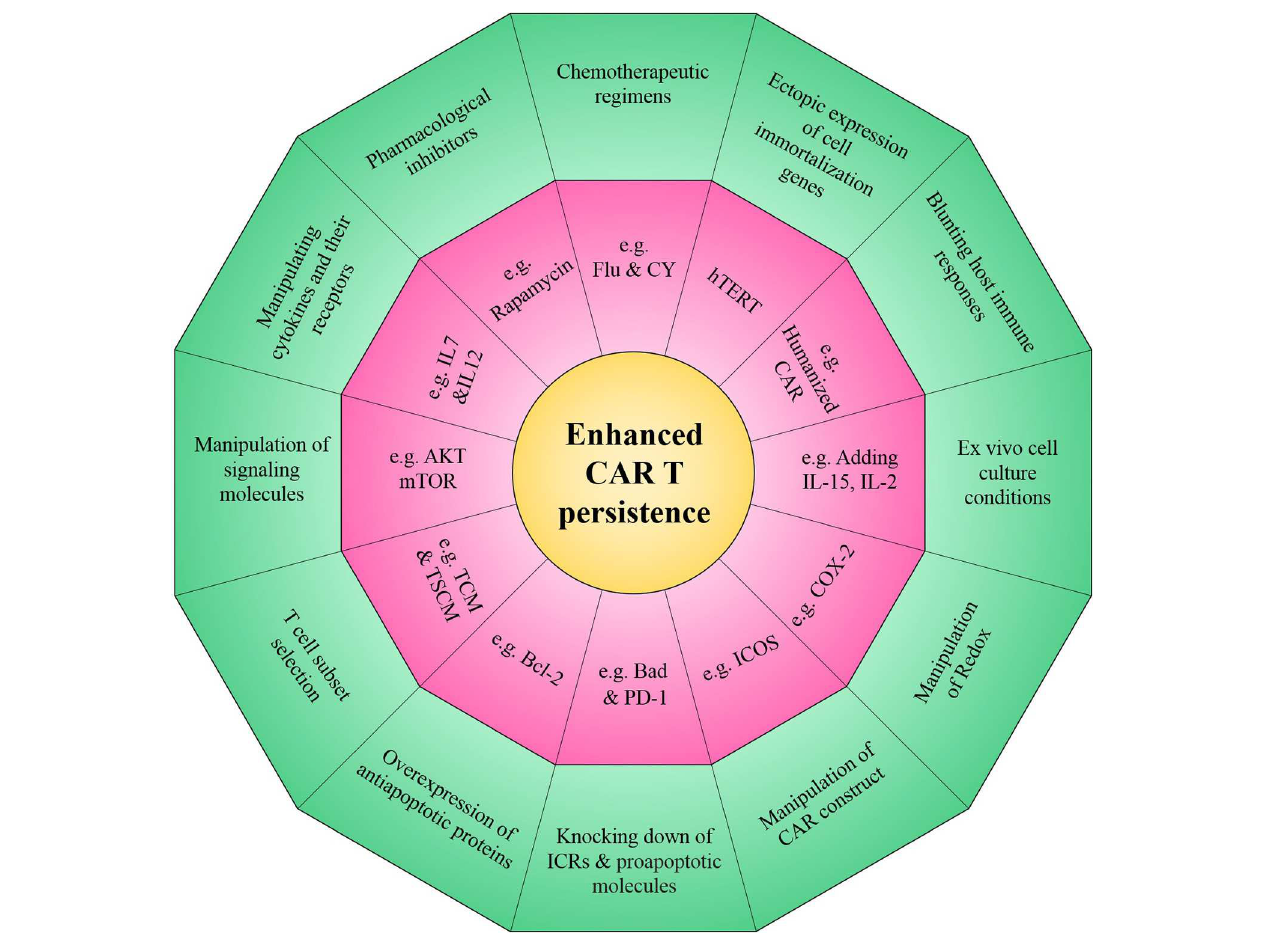
FIGURE 3 | Novel strategies to enhance the persistence of CAR T cells. The overall aim of these approaches is to improve intrinsic CAR T cell fitness and allow to elicit optimal CAR T cell persistence in the setting of many intrinsic and/or extrinsic barriers operative within a harsh tumor